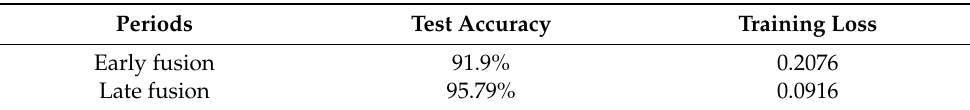
Table 6. Comparison of feature fusion in different periods.